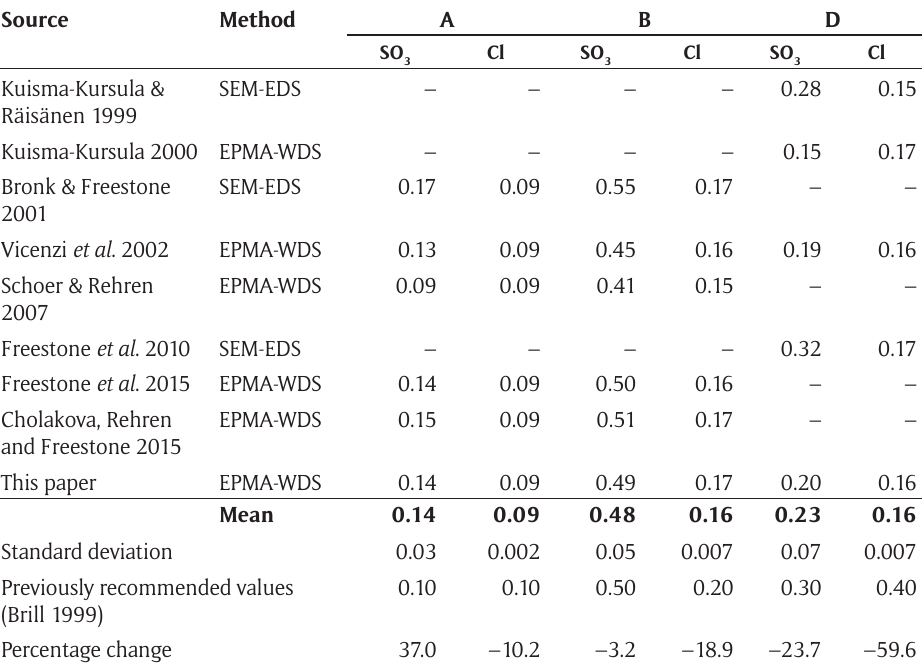
and Cl for Corning A, B and D alongside results of the cur- Table 2: Published results for SO 3 rent paper, expressed as oxide weight percent (wt%). The mean of all studies is compared with the recommended theoretical values published in Brill